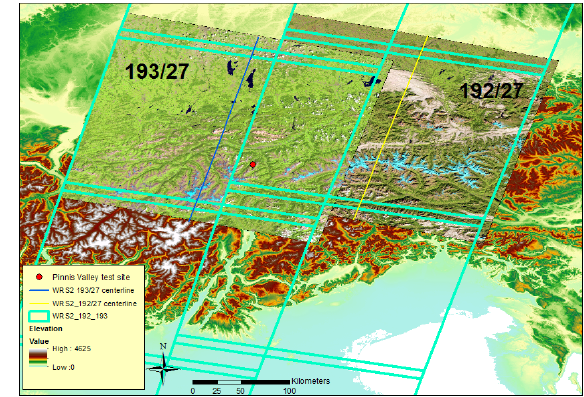
Figure 5: The Pinnis test site is located opportune on the over- lapping area of two descending Worldwide Reference System (WRS)-2 paths, shown in blue. As can be identified from the centerlines of the images acquired in row 27, the center of path 193 is closer to the test site than that of path 192. Also the view direction switches between the two acquisition